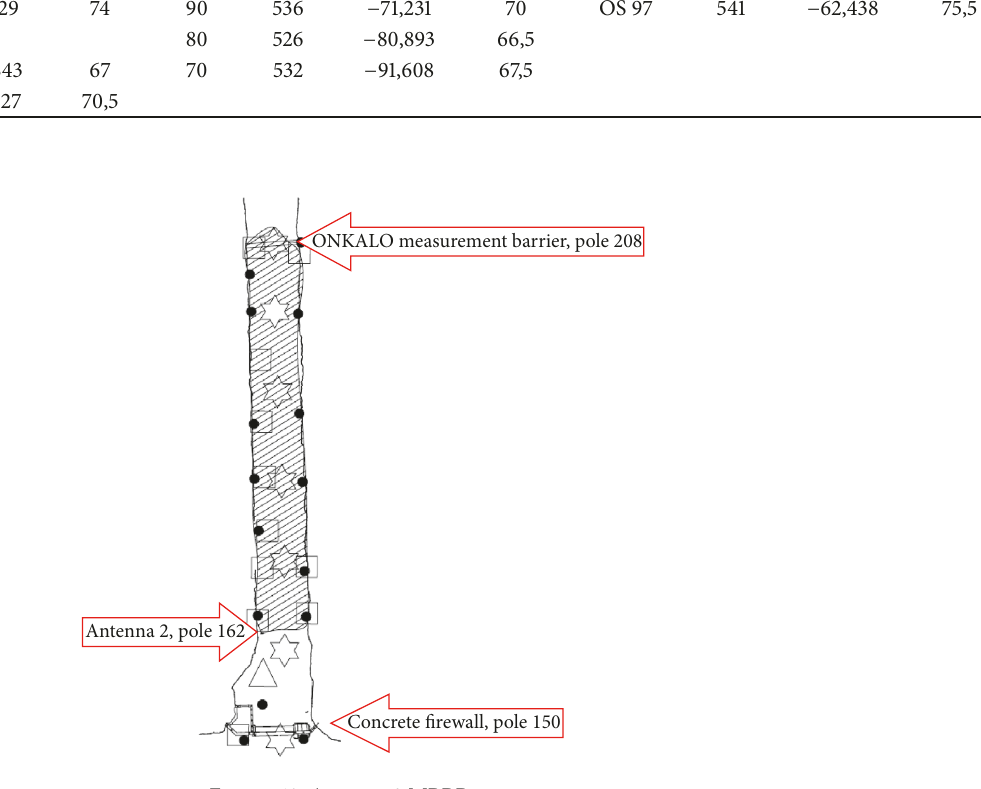
Figure 19: Antenna 2 MRRR